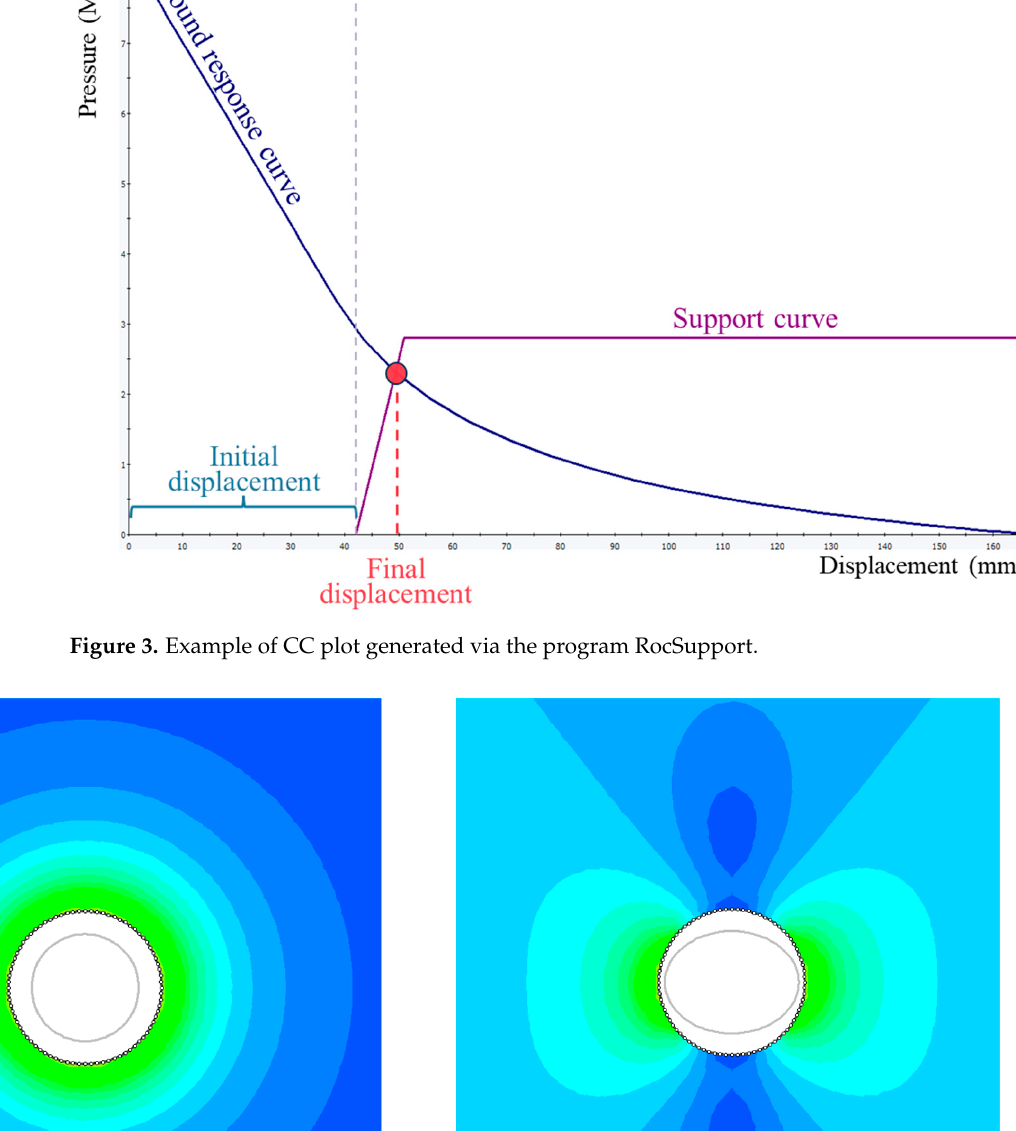
Figure 3. Example of CC plot generated via the program RocSupport .